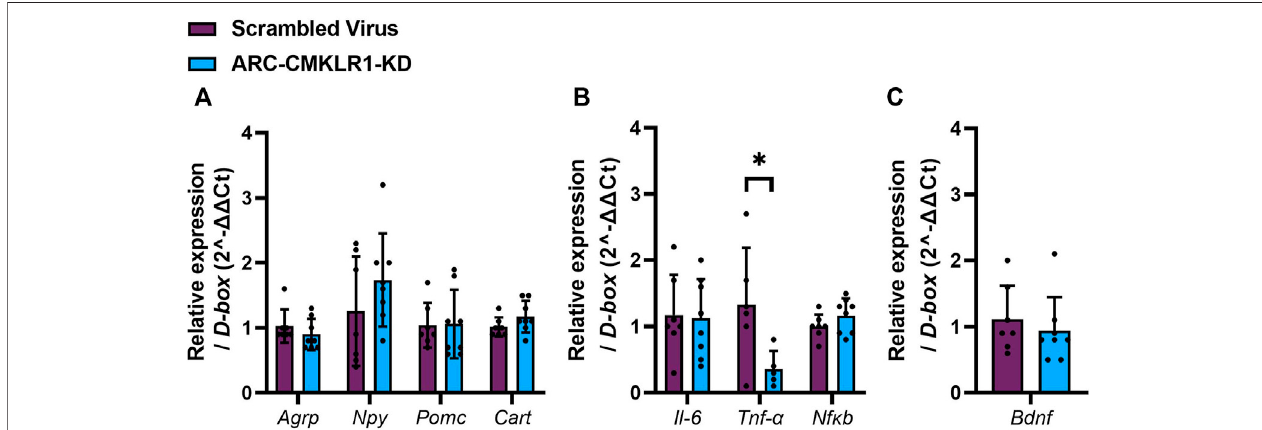
FIGURE4| Neuropeptides,in fl ammatorymarkersandtrophicfactorinthehypothalamus.AdultSpragueDawleyratsonhigh-fatdietreceivedabilateralinjectionof a shRNA construct targeted against CMKLR1 or a control construct ( n = 8/group). After surgery, the rats were maintained on a high-fat diet for 17 days and then switched to chow diet. (A) Hypothalamic neuropeptide mRNA expression of Agrp, Npy, Pomc and Cart mRNA remains unaltered in ARC-CMKLR1-KD rats. (B) No signi fi cant difference was found in Il-6 and Nf κ b mRNA levels, but Tnf- α is signi fi cantly downregulated in ARC-CMKLR1-KD rats. (C) Bdnf mRNA levels did not change. Data are presented as mean ±